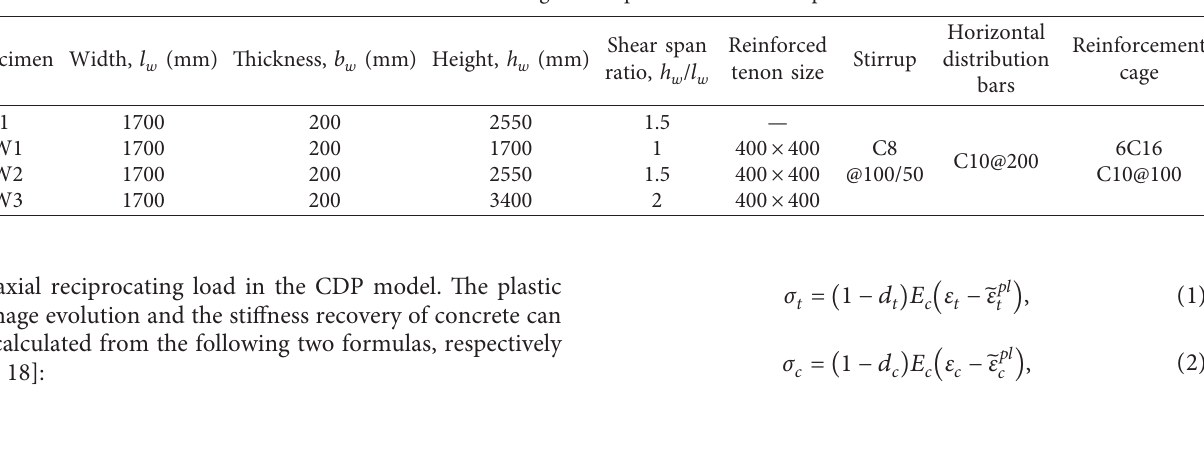
Figure 5: Dimensions of the specimen: (a) outline dimensions of the model; (b) cross section details of 1-1 and 2-2. Table 1: Reinforcement configuration parameters of four